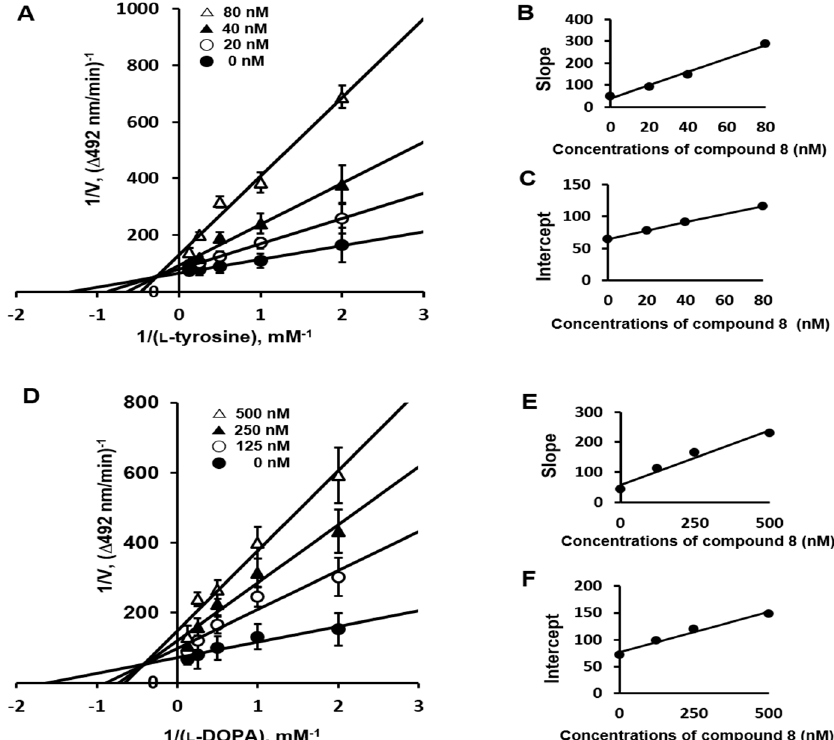
Figure 2. Enzyme kinetic studies of tyrosinase inhibition in the presence of compound 8 . Lineweaver-Burk plots for the inhibition of the monophenolase activity of mushroom tyrosinase at various concentrations ((0 nM (closed circle), 20 nM (open circle), 40 nM (closed triangle) and 80 nM (open triangle)) of compound 8 in the presence of di ff erent concentrations (0.5, 1, 2, 4 and 8 mM) of l -tyrosine ( A ) and the diphenolase activity of mushroom tyrosinase at di ff erent concentrations (0 nM (closed circle), 125 nM (open circle), 250 nM (closed triangle) and 500 nM (open triangle)) of compound 8 in the presence of l -DOPA (0.5, 1, 2, 4 and 8 mM) ( D ). The slopes for l -tyrosine ( B ) and for l -DOPA ( E ) and the intercepts for l -tyrosine ( C ) and for l -DOPA ( F ) are plotted as a function of the inhibitor concentration. Error bars indicate the standard error of the mean (SEM).